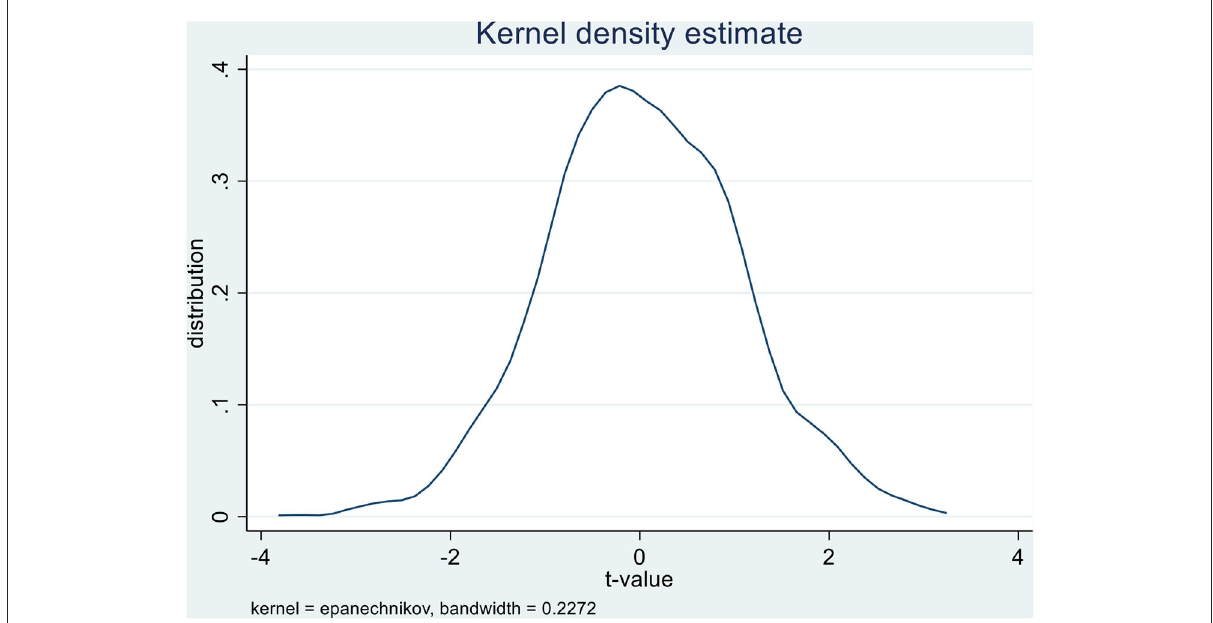
FIGURE3 Placebo test − 1,000 times distribution. This figure shows the placebo test distribution for 1,000 times regression results. It plots the t -value for the variable POLICY_TREAT around zero. Source: The author’s calculations are based on data from the sources indicated in Section Sample and data